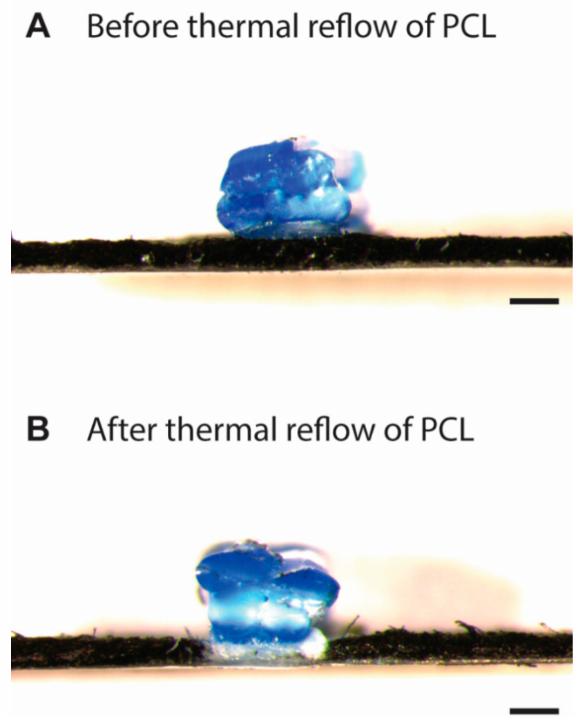
Figure 3. ( A ) Cross-sectional image of PCL and PLA printed on filter paper using an fused deposition modeling (FDM) printer before the thermal reflow. The layer of PCL was partially melted by the deposition of molten PLA from the top. ( B ) Cross-sectional image of PCL and PLA printed on filter paper after heating in an oven at 150 ◦ C for 60 min. The filter paper was dyed with black ink to enhance the contrast, and the penetration of the PCL was highlighted. Scale bars = 400 µ